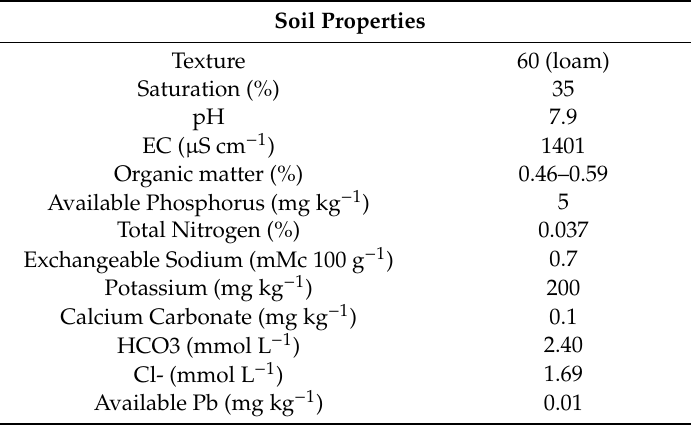
Table 4. Physico-chemical characterization of